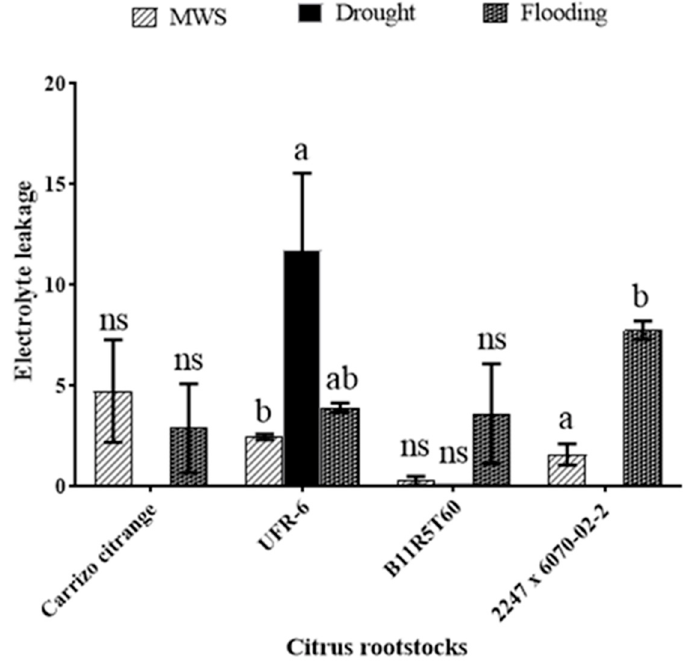
Figure 7. Electrolyte leakage (EL) at day 30 of the assay with the four citrus rootstocks studied (Carrizo citrange, UFR-6, B11R5T60, and 2247 x 6070-02-2) and under four water stress (Control, MWS, Drought, and Flooding). Values in columns with different letters denote statistical differences among treatments for each rootstock by Fisher’s LSD test ( p < 0.05). Note: data were not available for the Drought treatment of Carrizo citrange, B11R5T60, and 2247 x 6070-02-2. MWS: Medium Water Stress; ns: not significant.